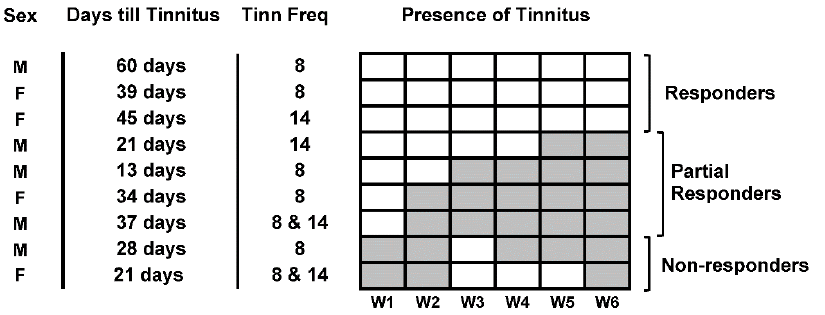
Figure 4. Figure showing absence (white box) or presence (grey box) of tinnitus for each animal in the 6 weeks post-treatment, illustrating that 3 animals showed sustained absence of tinnitus (responders), 4 animals that showed a gradual return of tinnitus (partial responders) and 2 animals in which treatment had no apparent effect (non-responders). Graph also indicates sex, days to develop tinnitus and tinnitus frequency (kHz) for each animal.